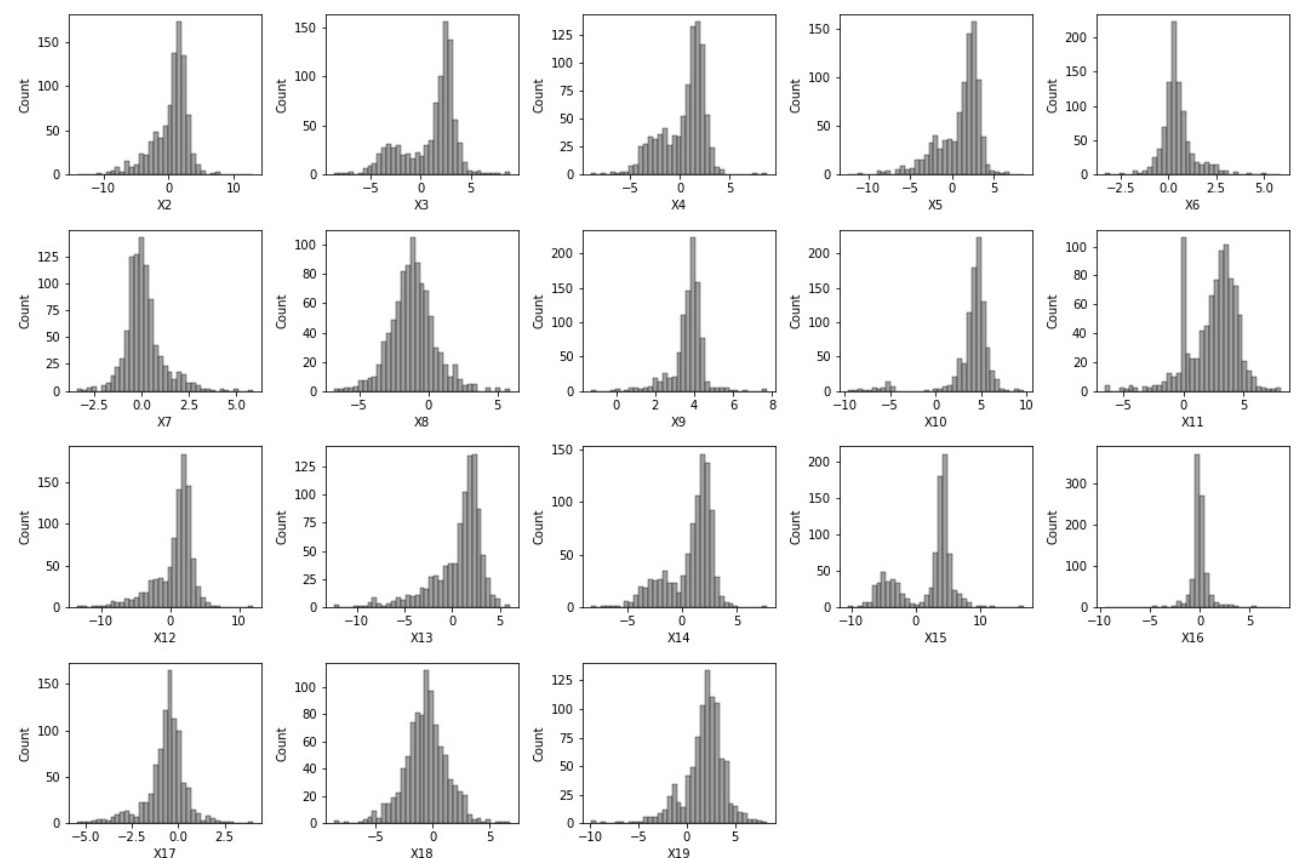
Figure 1. Histograms of the distributions of continuous variables after their transformation according to Formula (1).